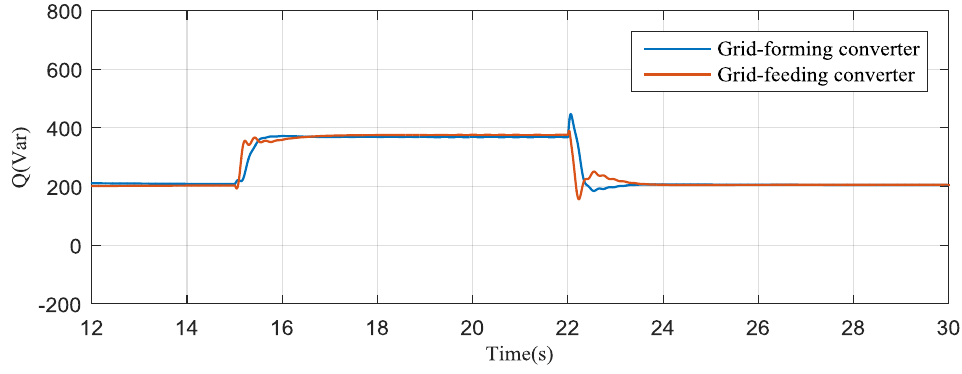
Figure 22. Reactive power of the proposed VSG control with virtual impedance.